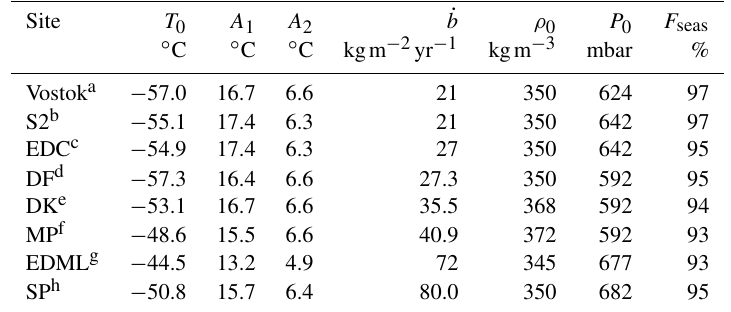
Table 2. Meteorological conditions and model parameters at the study sites. Listed are the annual mean temperature ( T 0 ), amplitude of the first two harmonics of the seasonal cycle ( A 1 , A 2 ), annual mass accumulation rate ( ˙ b ), firn surface density ( ρ 0 ), average atmospheric pressure ( P 0 ) and fraction of variance in ERA-Interim monthly surface temperature explained by the seasonal cycle alone ( F seas ). If borehole temperature measurements exist, we use the 10m firn temperature for T 0 instead of air temperature observations, as they provide a more accurate estimate of the relevant temperature for the diffusion. If no temperature observation exists, the temperature from the nearest site was used by adding the temperature anomaly between the sites from reanalysis data (Dee et al., 2011).